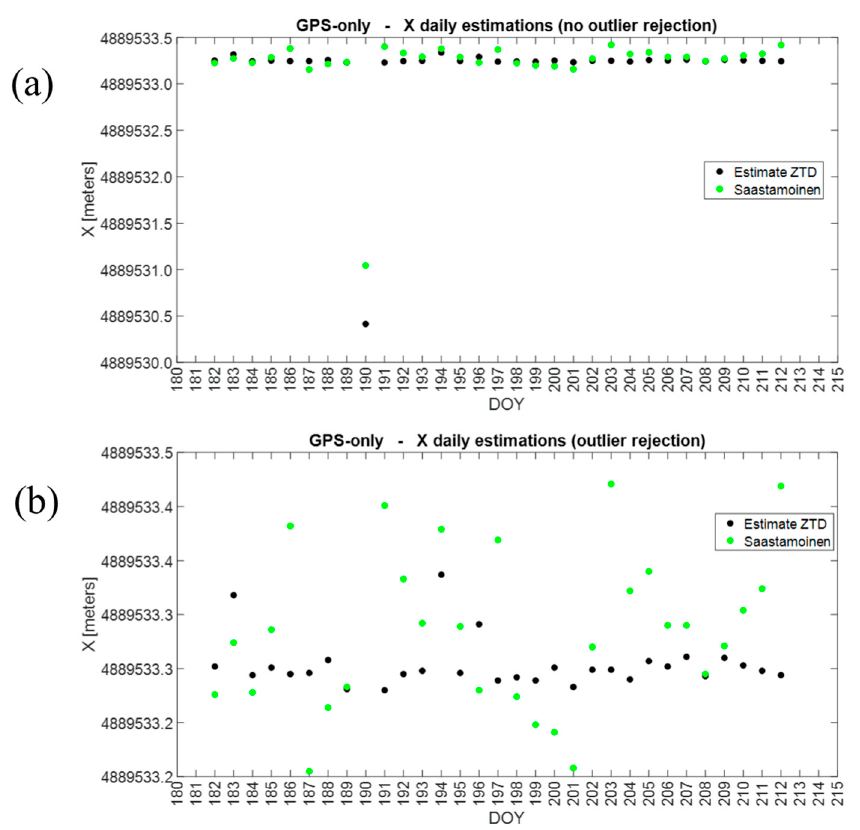
Figure 8. Daily estimations of X component with Saastamoinen and Estimate ZTD (Zenith Troposhperic Delay) tropospheric models in case of GPS-only configuration ( a ) no outlier rejection ( b ) outlier rejection. Table 2. Standard deviation of the considered GNSS combinations with Saastamoinen and Estimate ZTD (Zenith Troposhperic Delay) tropospheric models.